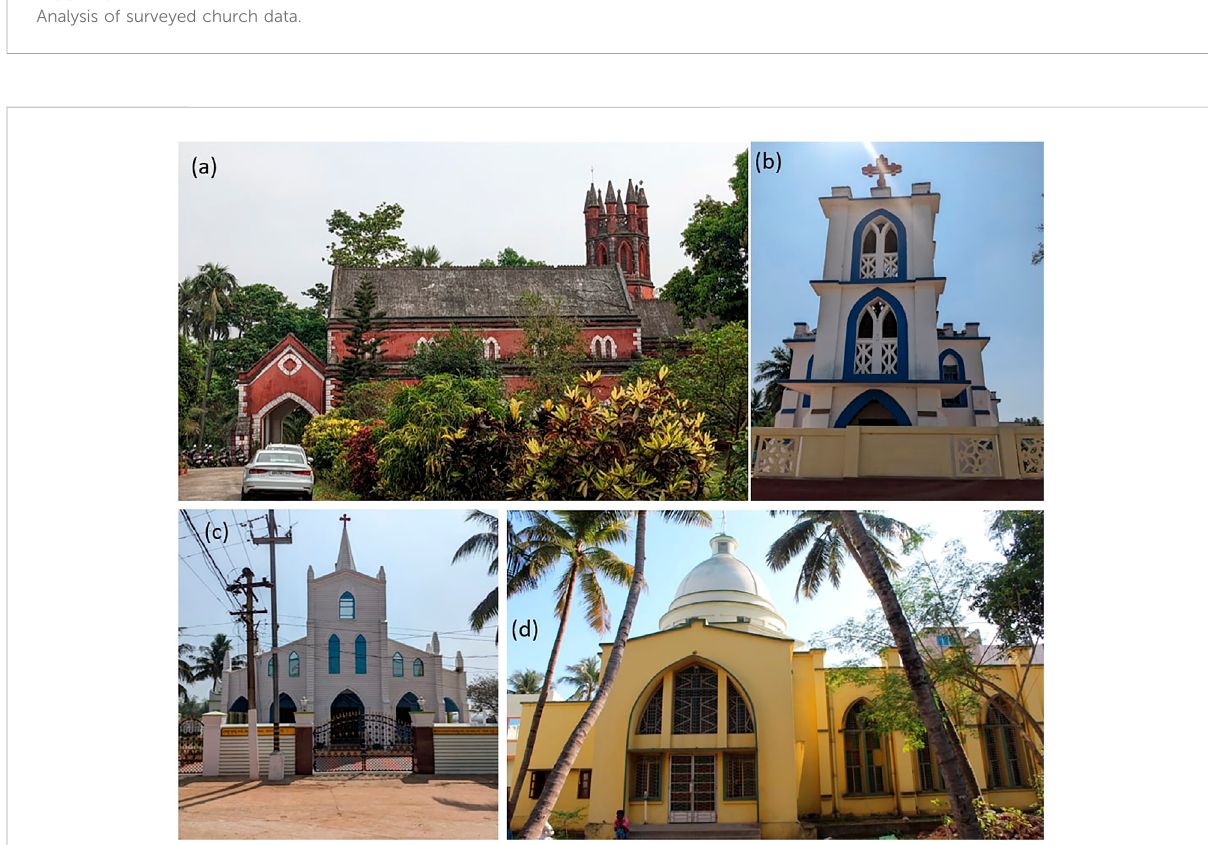
FIGURE 4 (A) Church of Epiphany, Cuttack (B) Sacred Heart Church, Jatni (C) Bahilipada church, Barakuda (D) St. Vincent Pro ’ s Cathedral, Bhubaneswar.